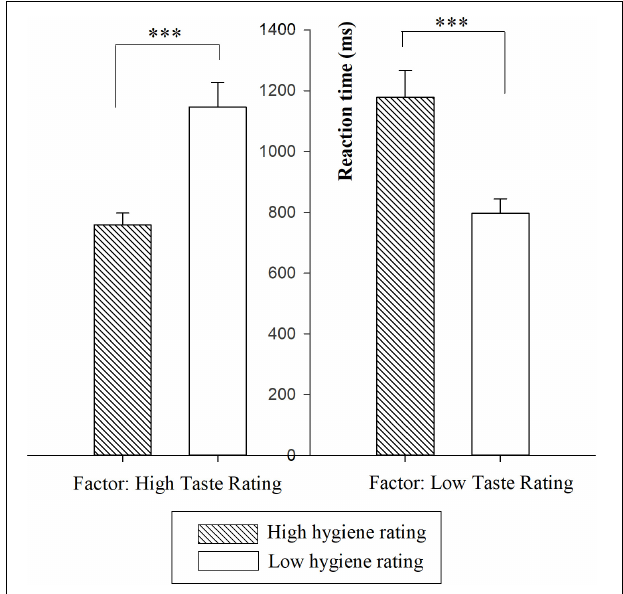
FIGURE 4 | Reaction time (RT) results for all experimental conditions in Study 2. The error bars indicate standard error of the mean. ∗∗∗ p < 0.001.